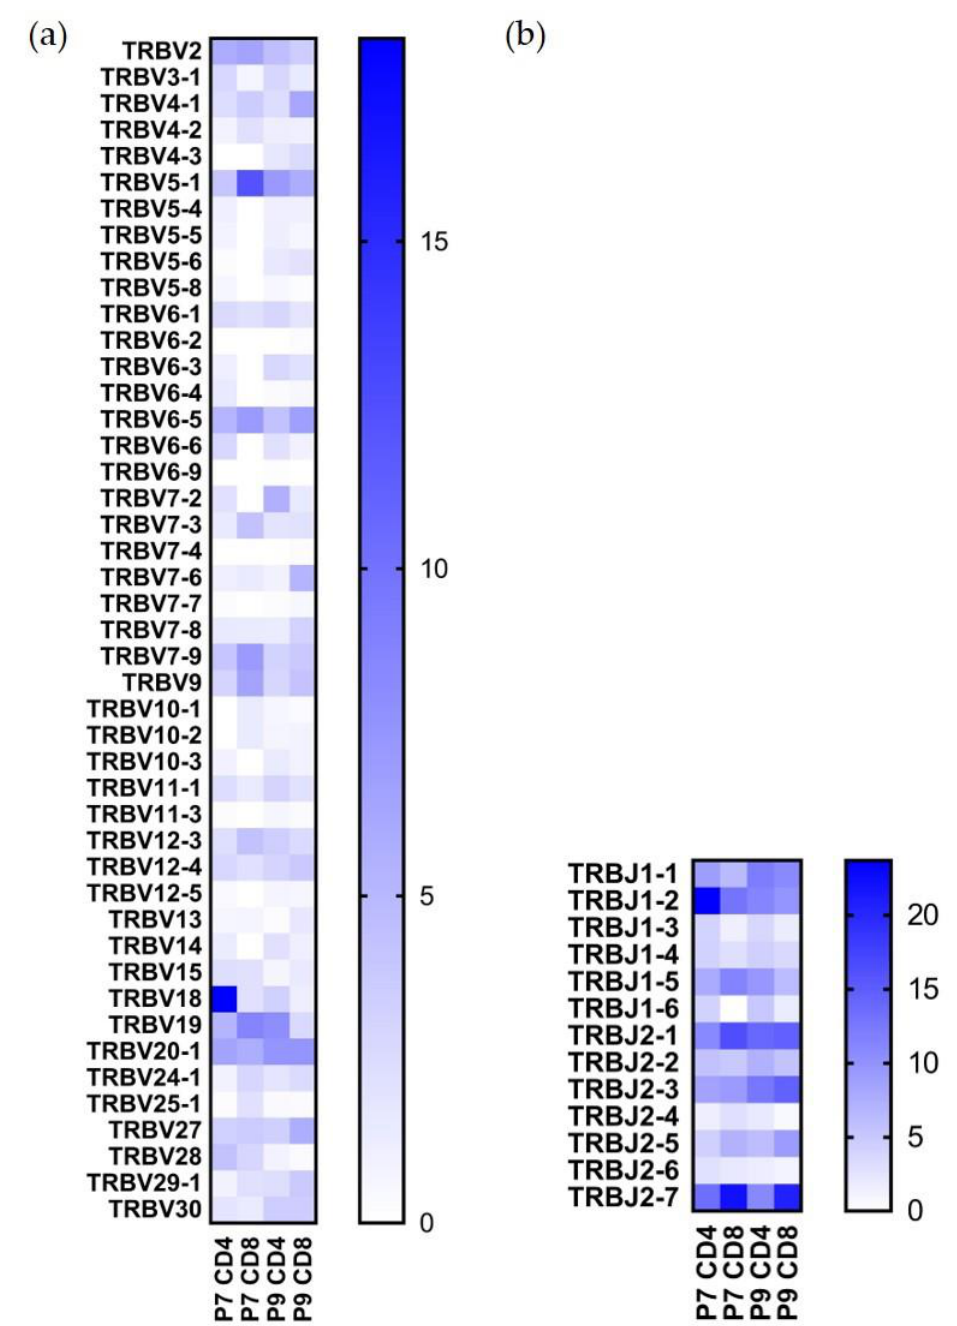
Figure 2. TRBV and TRBJ usage in Ni 2+ -reactive CD4+ and CD8+ T cell clones in P7 and P9 subjects. ( a ) Percentage of the TRBV gene usage. ( b ) Percentage of the TRBJ gene usage. All gene names are in IMGT nomenclature. The scale reflects the percentage present in each designated population.